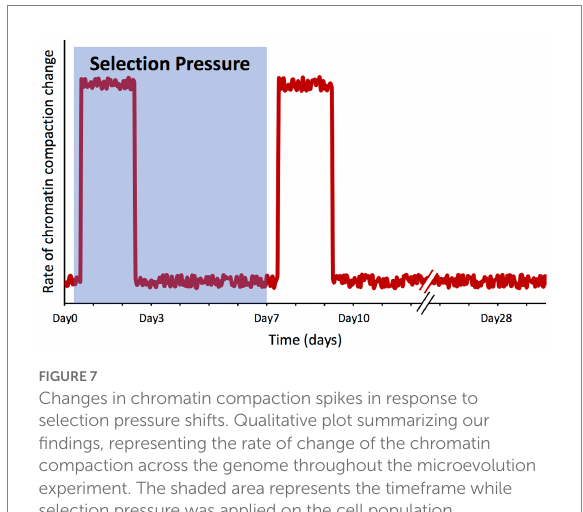
FIGURE 7 Changes in chromatin compaction spikes in response to selection pressure shifts. Qualitative plot summarizing our findings, representing the rate of change of the chromatin compaction across the genome throughout the microevolution experiment. The shaded area represents the timeframe while selection pressure was applied on the cell